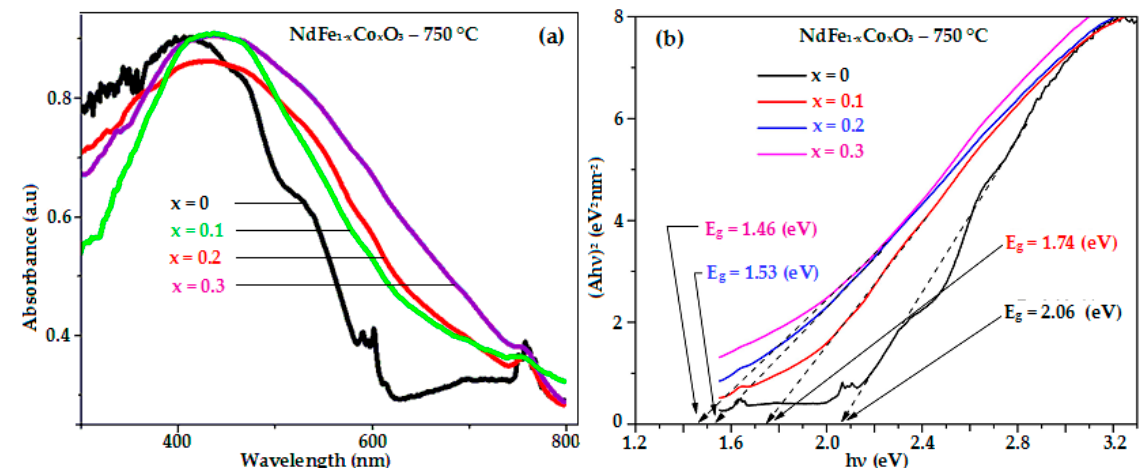
Figure 3. Transmission electron microscopy (TEM) images and particle size distribution of NdFe 1-x Co x O 3 samples an- nealed at 750 °C . Figure 4. ( a ) Room-temperature optical absorbance spectra and ( b ) plot of (Ah ν ) 2 as a function of photon energy for NdFe 1- x Co x O 3 materials annealed at 750 °C for 60 min .